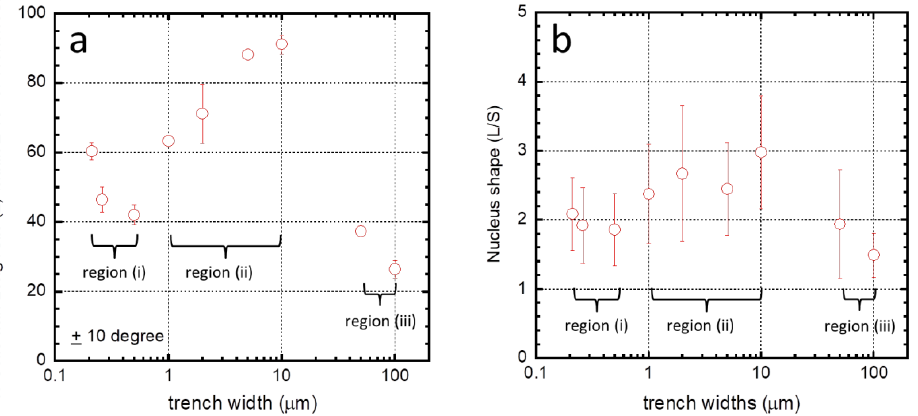
Figure 8. ( a ) Percentage of cells in which the long axis (L) of their nucleus aligned within ±10° of the trench axis when adhered on comb structures with varying trench widths. Results show cell orientation depends strongly on trench width. Three different regimes are observed with widths between (i) 0.21–0.5 μm, (ii) 1–10 μm, and (iii) 50–100 μm; ( b ) nucleus shape (as defined by the